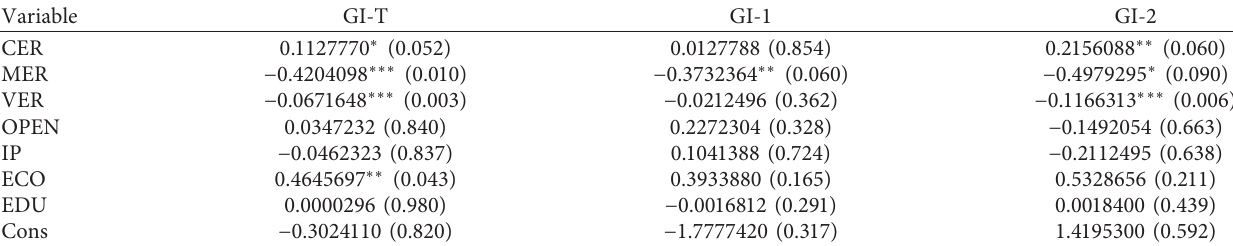
Table 10: Robustness